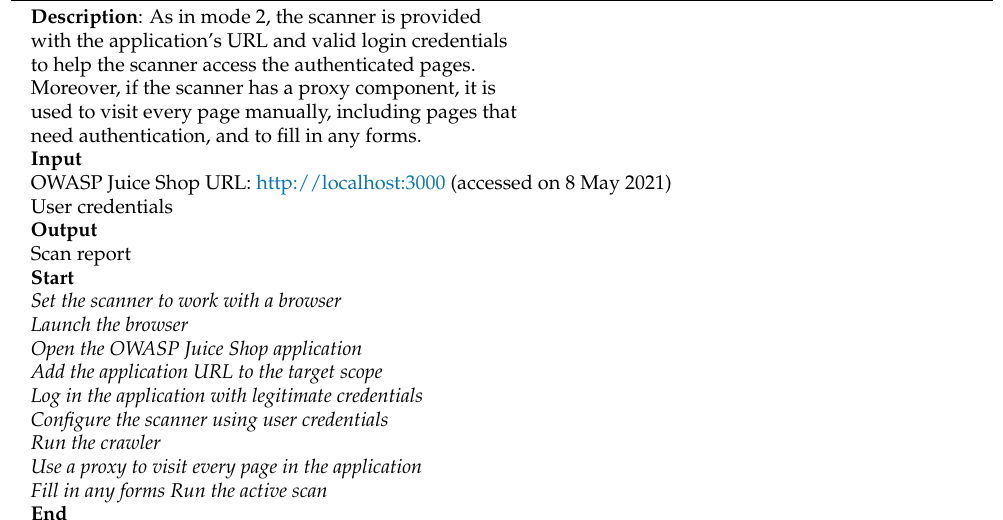
Algorithm 4 Mode 4: Authenticated scan with